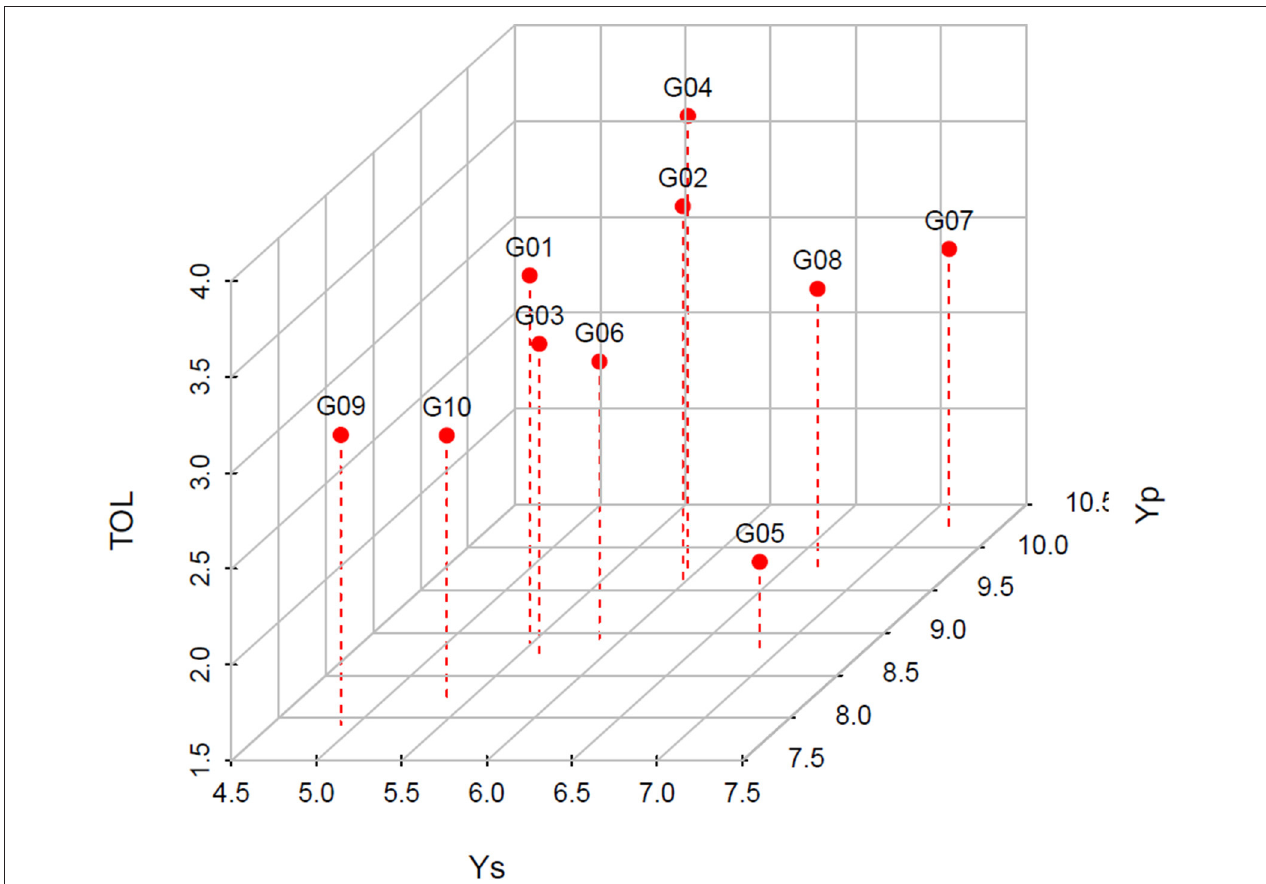
FIGURE 3 | The average yields of each genotype under waterlogging (Ys) and normal (Yp) conditions and the tolerance (TOL) values.